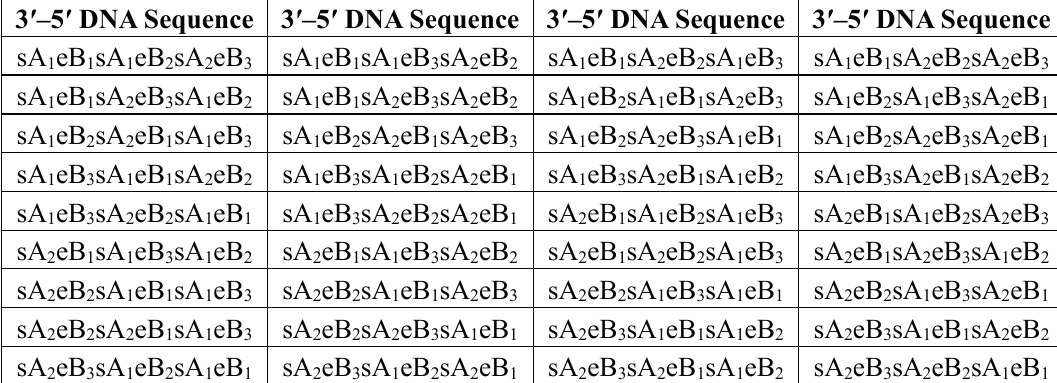
Table 5. DNA Sequences symbols after Step (1) for Table 2.